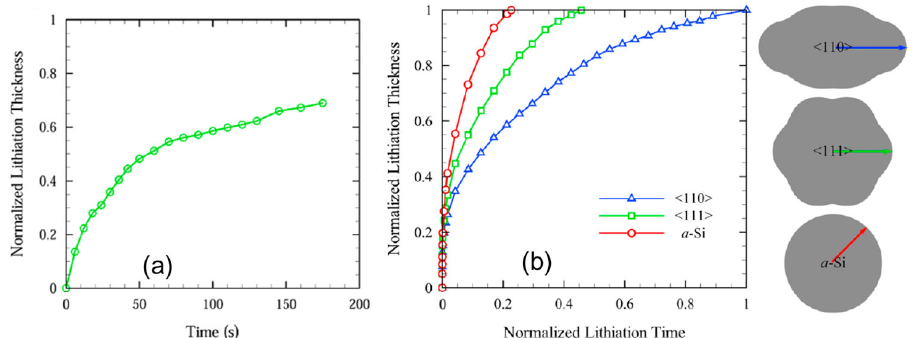
Fig. 4 Lithiation retardation in GeNWs. a The plot of the thickness of lithiated shell (normalized by the thickness of the pristine GeNW) as a function of the lithiation time shows lithaition rate decreases with time. b The retardation effect is stronger with stronger lithiation anisotropy. The lithiation dynamics is measured along < 110 > directions in the c -SiNWs and an arbitrary direction in the a -SiNW